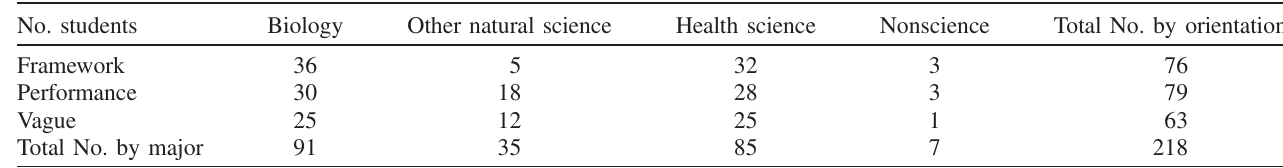
TABLE I. Students categorized into problem-solving exercise orientations, per end-of-semester survey responses. No. students